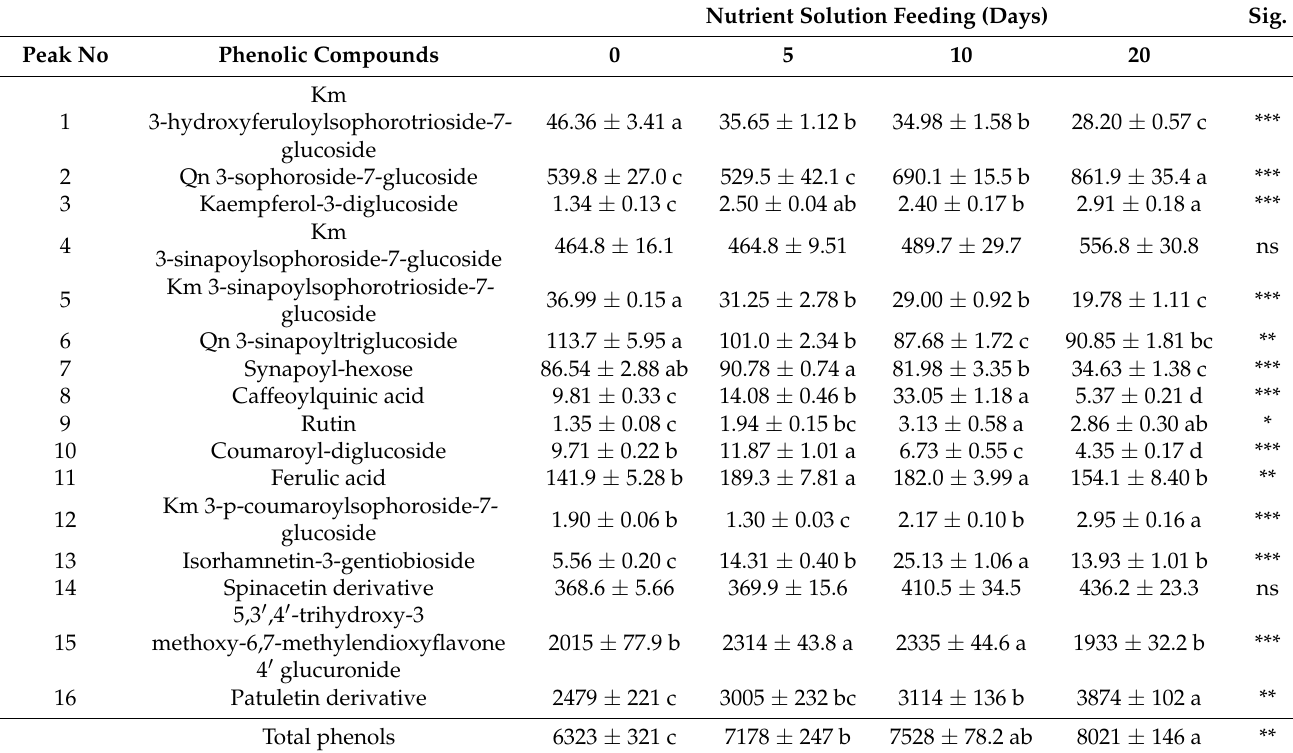
Table 4. Polyphenol composition ( µ g 100 g − 1 fw) in relation to nutrient solution feeding regime (means ± SD). Nutrient Solution Feeding (Days)